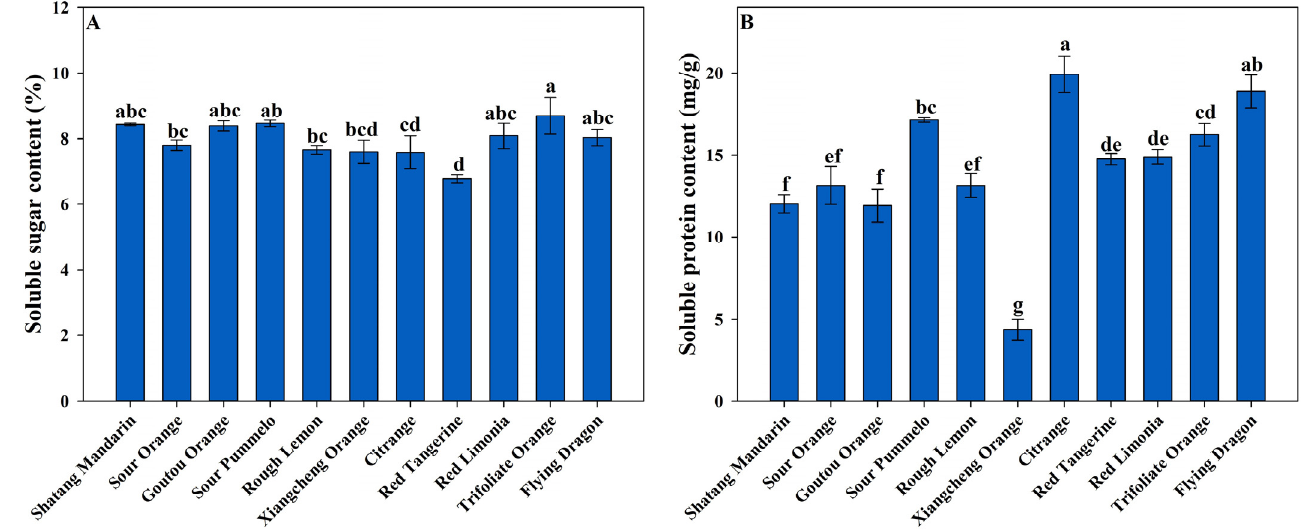
Figure 1. Soluble sugar and protein contents in leaf tissues of ‘Shatangju’ scion cultivar grafted onto different rootstocks. Soluble sugar content ( A ), soluble protein content ( B ). Error bars indicate the standard error of three biological replicates, and lowercase letters indicate significant differences between rootstocks by LSD ( p ≤ 0.05).